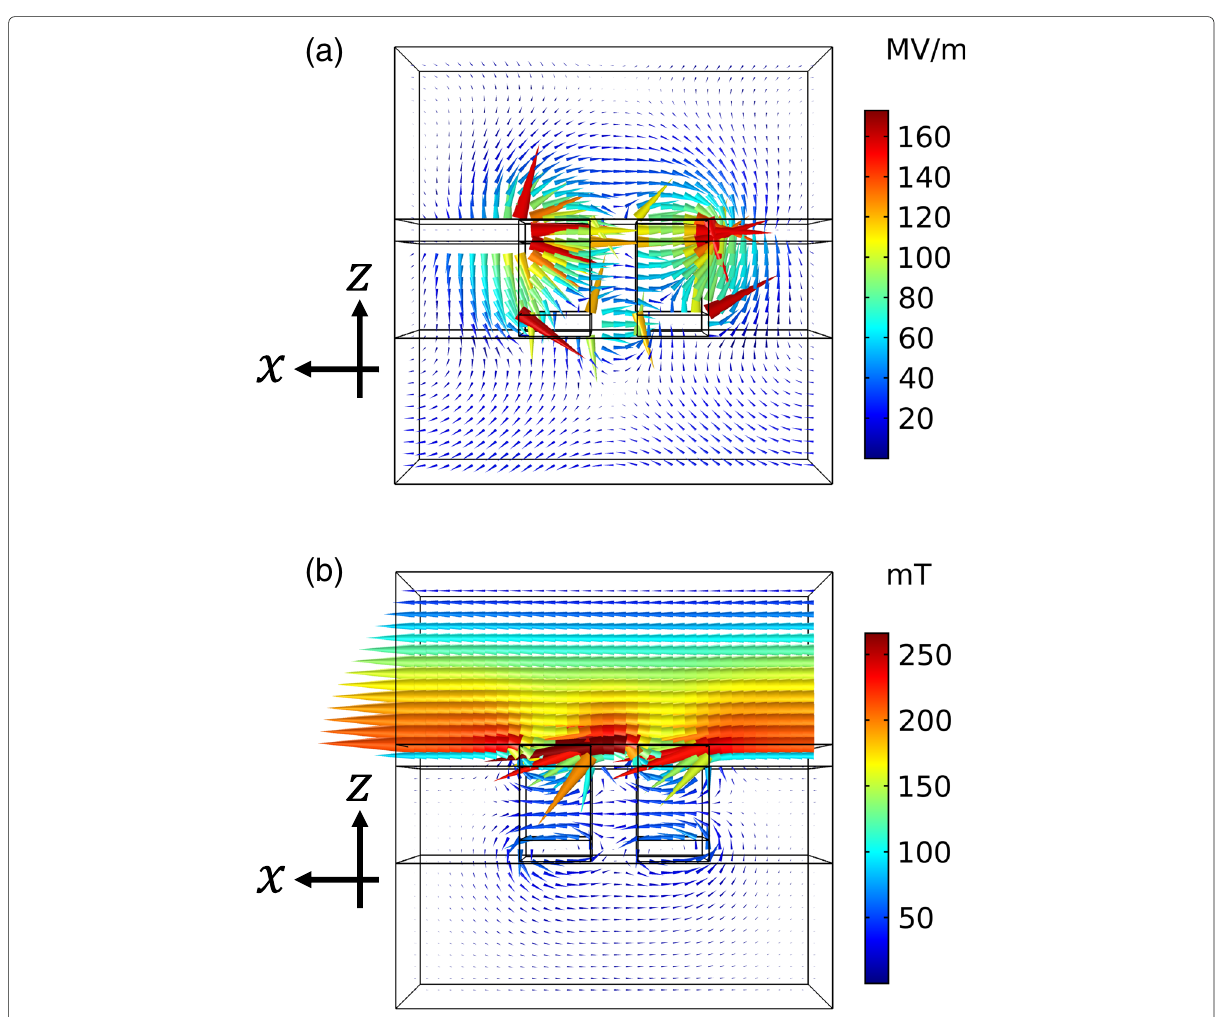
Fig. 13 a Electric field distribution pattern at the peak of the high transmittance shown in Fig. 6. b Magnetic field distribution pattern at the dip of the low transmittance shown in Fig. 6. The pseudo color indicates the intensity of the vector